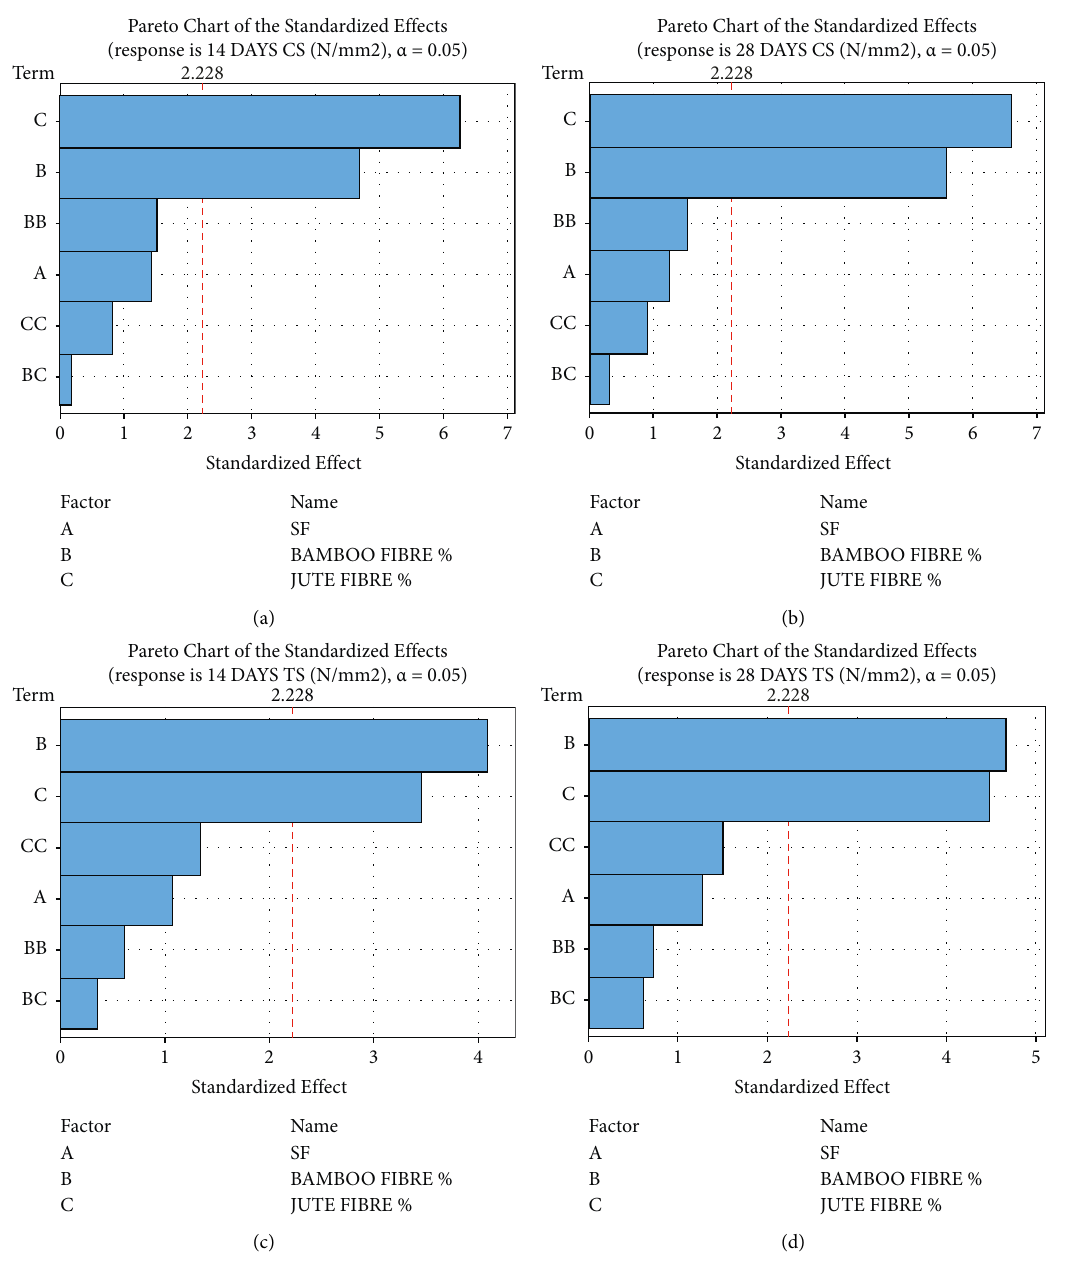
Figure 7: Pareto chart for (a) fcs